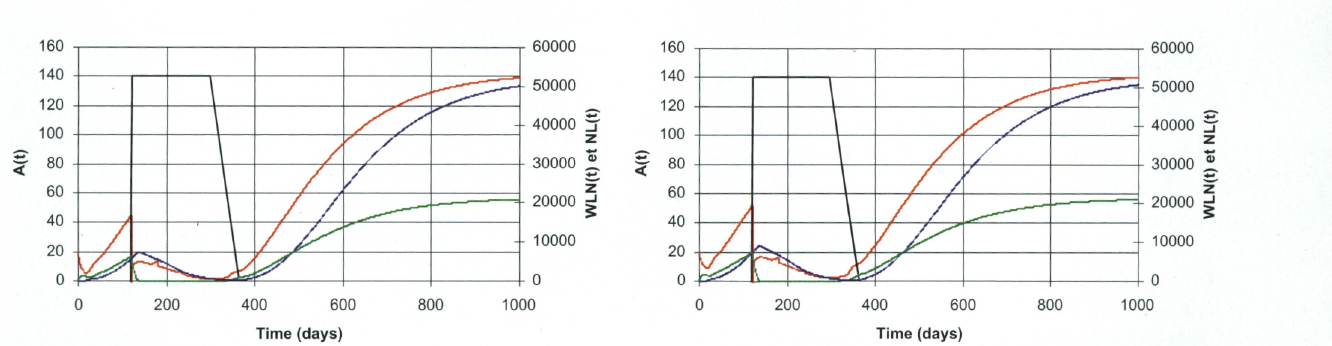
Fig. 18. - Treatment of host animal combining persistent insecticide and topical (spot-on) IGR at D 120, D 180 and D 240, which cor­ responds to application of this association every two months.